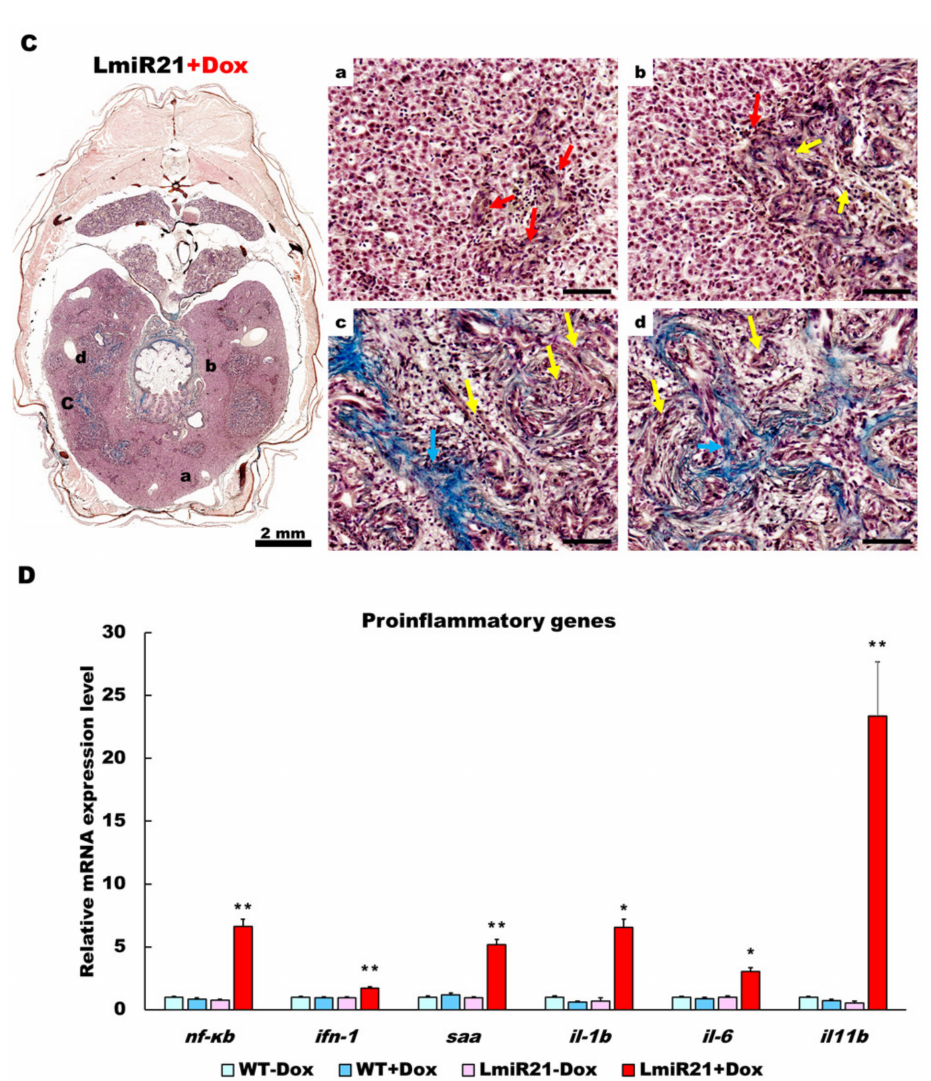
Figure 4. Development of nonalcoholic steatohepatitis (NASH) phenotypes in LmiR-21 zebrafish at 6 mpf. ( A ) Gross liver images of ( a ) LmiR21 − Dox male, ( b ) LmiR21 + Dox male, ( c ) LmiR21 − Dox female, ( d ) LmiR21 + Dox female. Scale bar: 3 mm. ( B ) Representative images of Masson’s trichrome staining of steatohepatitis in livers of (1) LmiR21 − Dox (insets a-d) and (2) LmiR21 + Dox; Insets: ( a ) hepatocyte ballooning, ( b ) Mallory-Denk bodies (MDBs) are indicated by arrows, and ( c , d ) lobular inflammation is indicated by arrows. Scale bar: 50 µ m. ( C ) Representative images of Masson’s trichrome staining of fibrotic liver tissue from LmiR21 + Dox; Insets: ( a , b ) MDBs concomitant with fibrosis (red arrows) and scar tissue associated with liver fibrosis (yellow arrows) and ( c , d ) lobular inflammation concomitant with blue collagen (blue arrows). Scale bar: 50 µ m. ( D ) Induction of proinflammatory gene expressions in response to inflammation was significantly greater in LmiR21 + Dox than in controls ( n = 3). Statistically significant differences from LmiR21 − Dox were denoted by * ( p < 0.05), ** ( p <